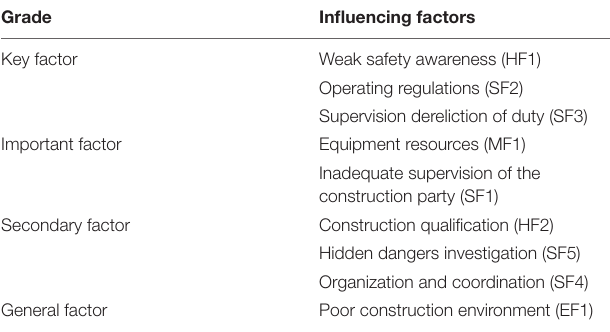
TABLE 6 | Identification of influencing factors of construction workers’ unsafe